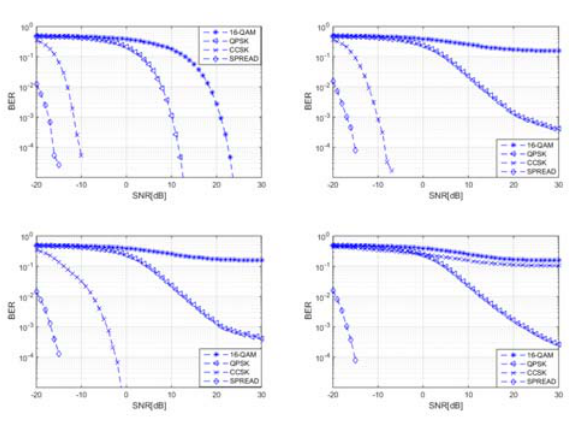
Figure 5. BER simulation of different interference